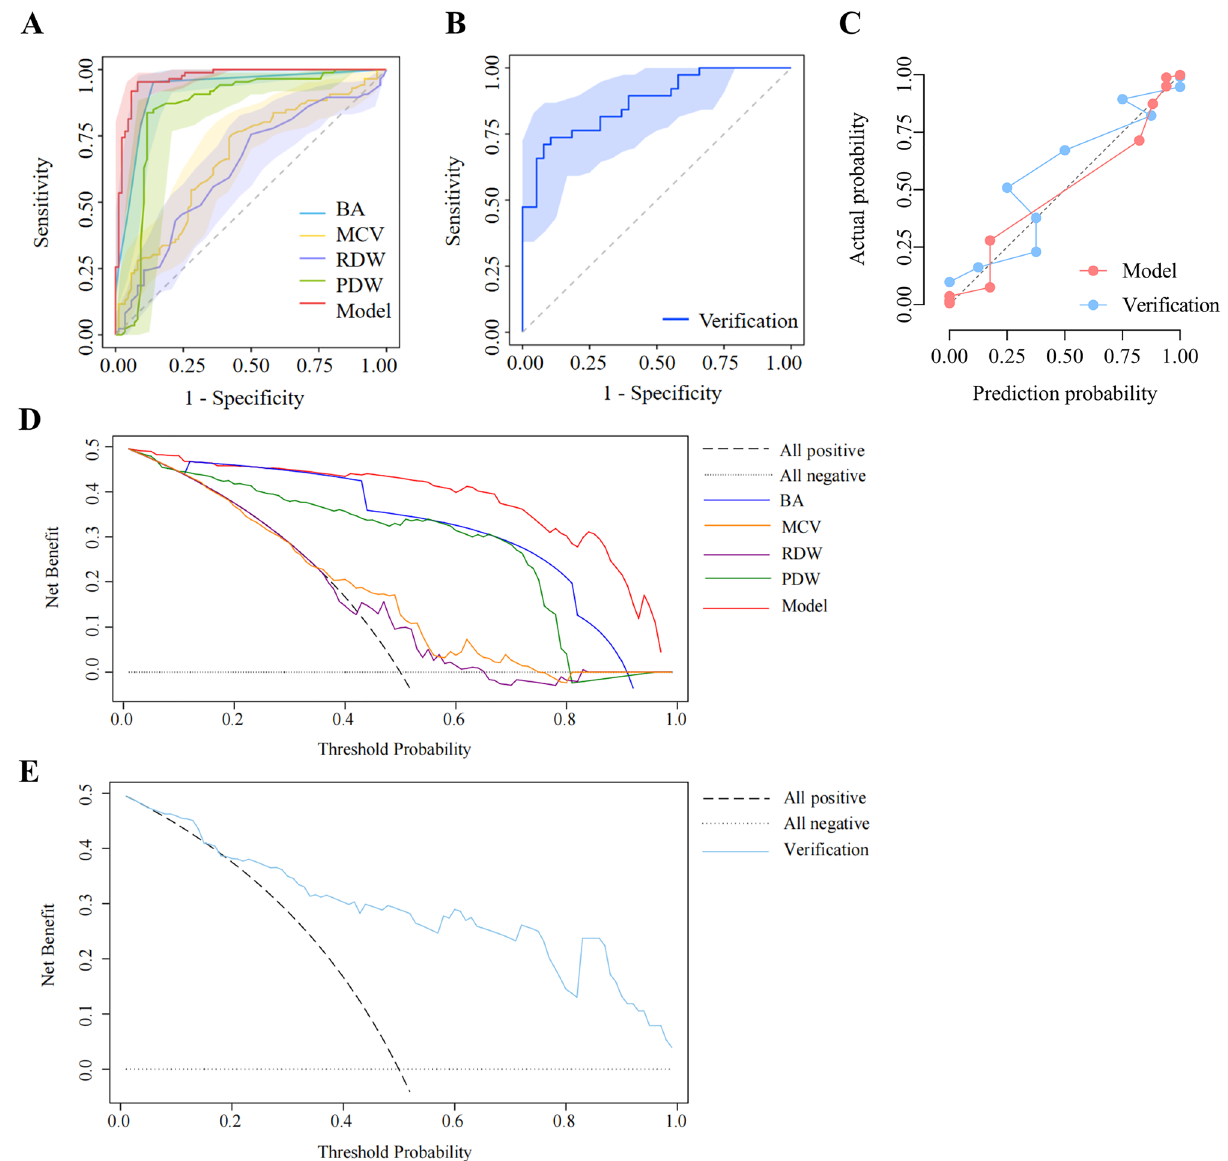
Figure 5. Model performance in the training and verification cohorts. ( A ) Receiver operating characteristic curve of training cohort. ( B ) Receiver operating characteristic curve of verification cohort. ( C ) Calibration curve. ( D ) Decision curve analysis of training cohort; ( E ) decision curve analysis of verification cohort. Model, Combined model of basophil, mean corpuscular volume, red blood cell distribution width and platelet distribution width; the shaded parts represented the 95% confidence interval of the areas under receiver operating characteristic curves.